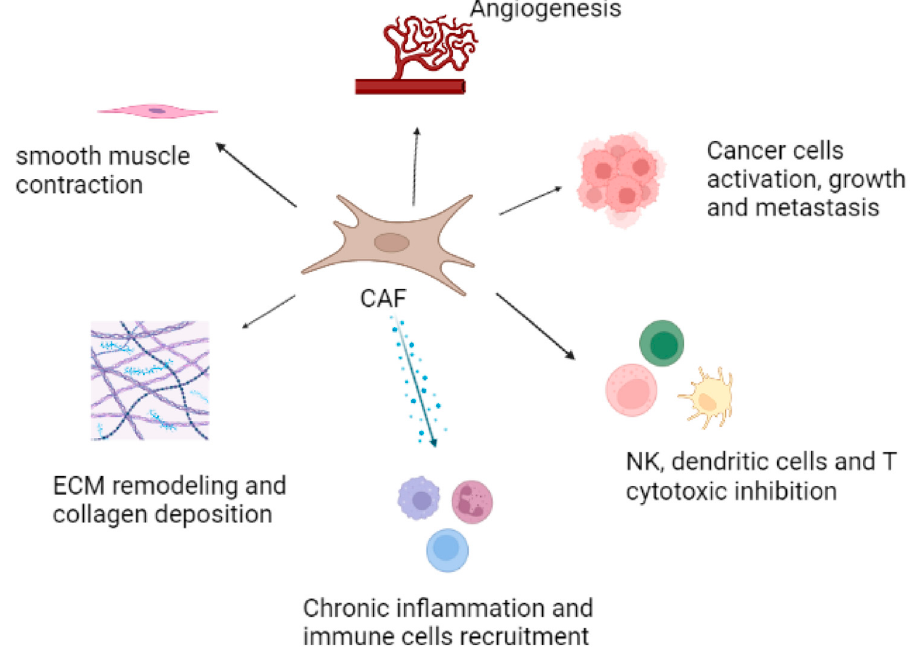
Figure 2. Features and functions of CAFs in TME. The major roles played by CAFs are represented in the figure: CAFs promote angiogenesis, induce smooth muscle contraction, stimulate ECM remodeling and collagen deposition, and boost cancer growth and metastasis, chronic inflammation, and immune inhibition.